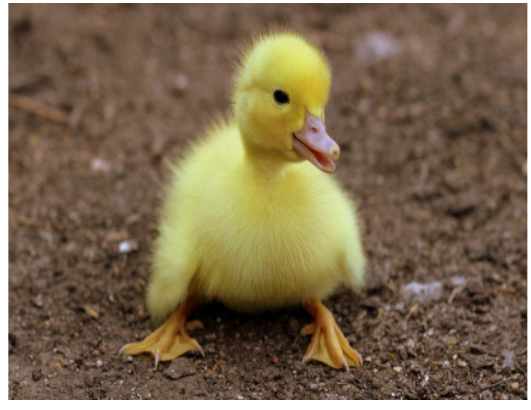
Figure 3.2 Segmented Fog Image